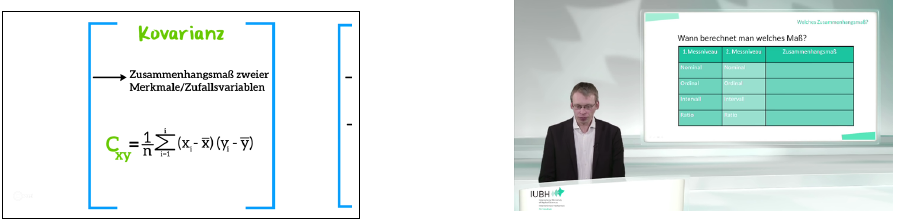
Figure 3. Frames from Video 2 ( left ) and Video 3 ( right ) illustrating their very different design strategies, both with respect to each other and to Video